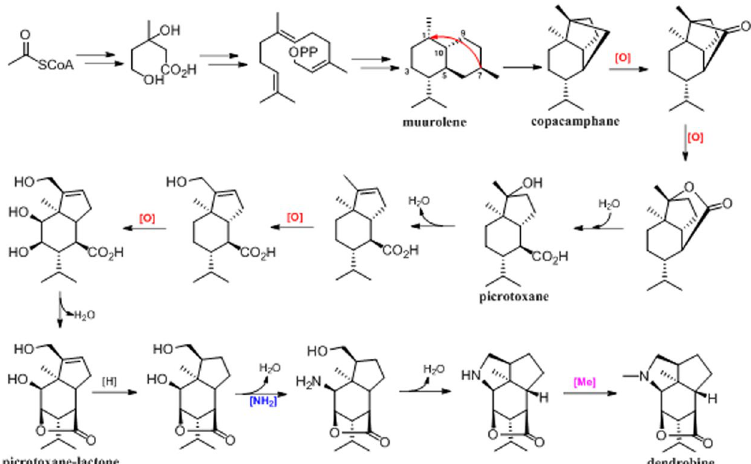
Figure 11. Postulation of the dendrobine biosynthetic